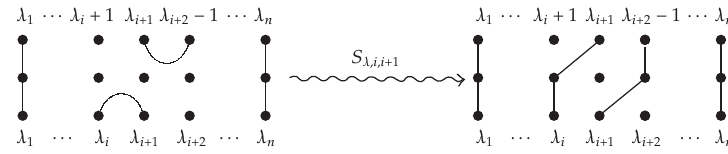
Figure 9: Cobordism S λ,i,i (cid:9) 1 .